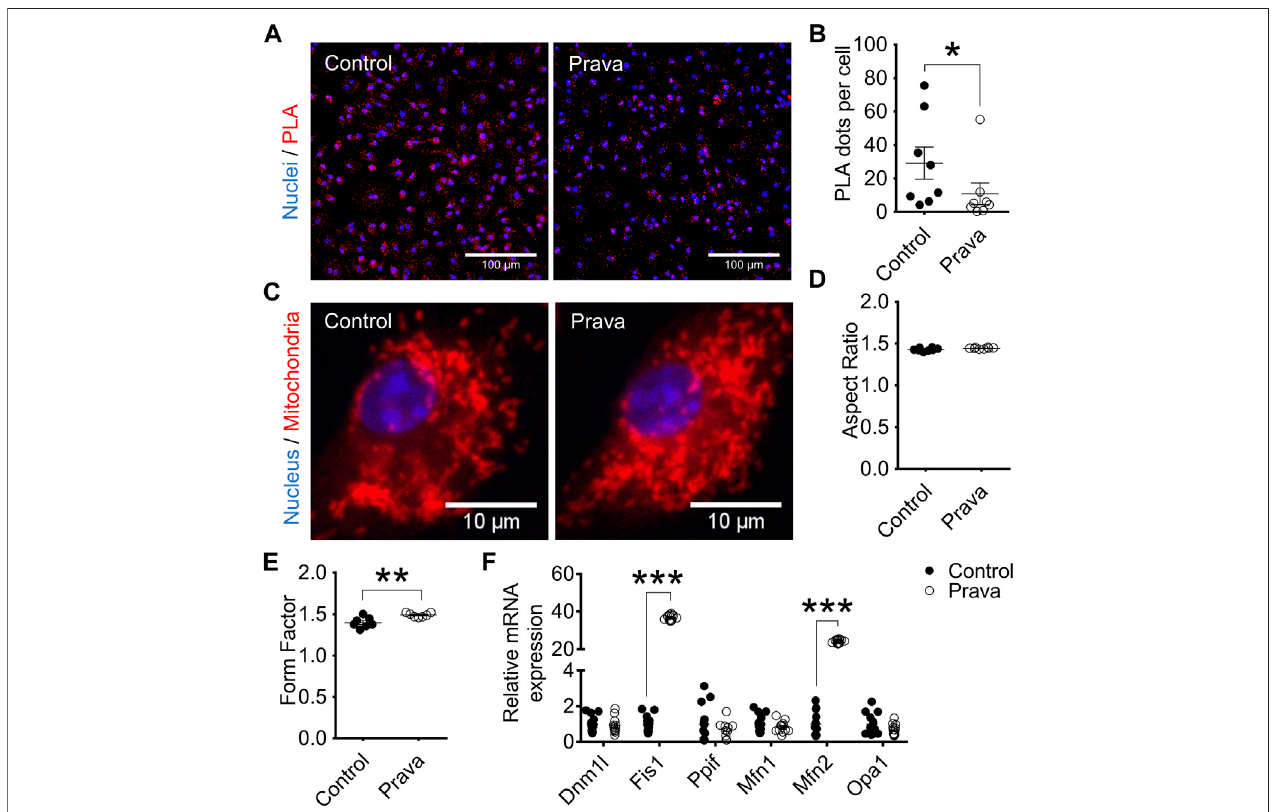
FIGURE 4 | Pravastatin reduces ER – mitochondria interaction, increases mitochondrial branching, and upregulates Fis1 and Mfn2 gene expression in BMDM. (A) Representative PLA images at 40× magni fi cation and (B) quantitative analysis of Ip3r1-Vdac1 interaction in BMDM from non-treated (control) and pravastatin-treated (prava)LDLr − / − mice. Tworeplicates per mouse wereconsidered, each corresponding tothe average ofnine fi elds analyzed by fl uorescence microscopy. Control: n =8 mice and prava: n = 8 mice. Statistical analyses were performed using a two-tailed nonparametric Mann – Whitney test. (C) Representative images of the mitochondrial network at 60× magni fi cation and quantitative analysis of mitochondria aspect ratio (D) and form factor (E) . Four replicates per mouse were considered, each correspondingto the average ofnine fi elds analyzed by fl uorescence microscopy.Dataare expressed asmean ±SE. Control: n =8 mice and prava: n = 8micefor aspect ratio analysis, and control: n = 7 mice and prava: n = 7 mice for form factor analysis. (F) Relative gene expression of mitochondrial fusion and fi ssion markers in BMDM.Control: n =13miceandprava: n =12mice.Dataareexpressedasmean±SE.Statisticalanalyseswereperformedusingatwo-tailedunpairedStudent ’ st-test. *, **, and *** represent p < 0.05, 0.01, and 0.001,